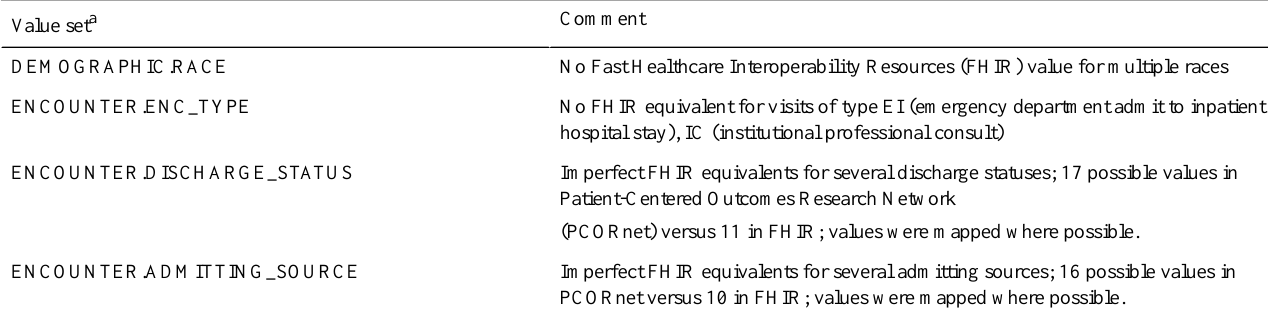
Table 4. Patient-Centered Outcomes Research Network 4.1 value sets with no (noncustom) exact Fast Healthcare Interoperability Resources equivalents. CommentValue set